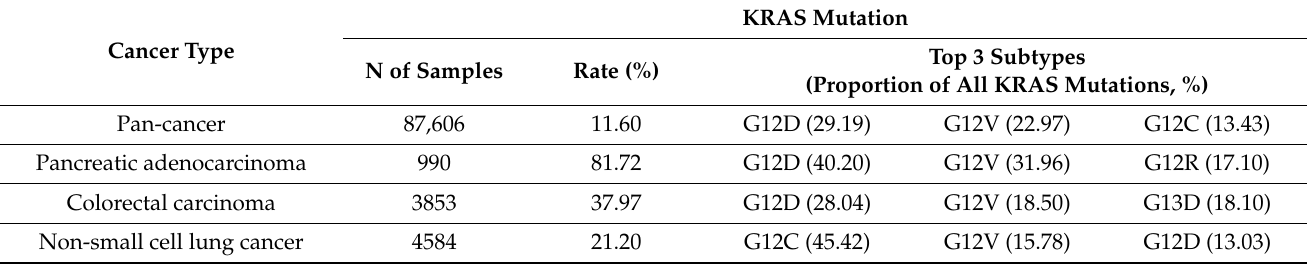
Table 1. KRAS mutation rate and subtype proportion in common